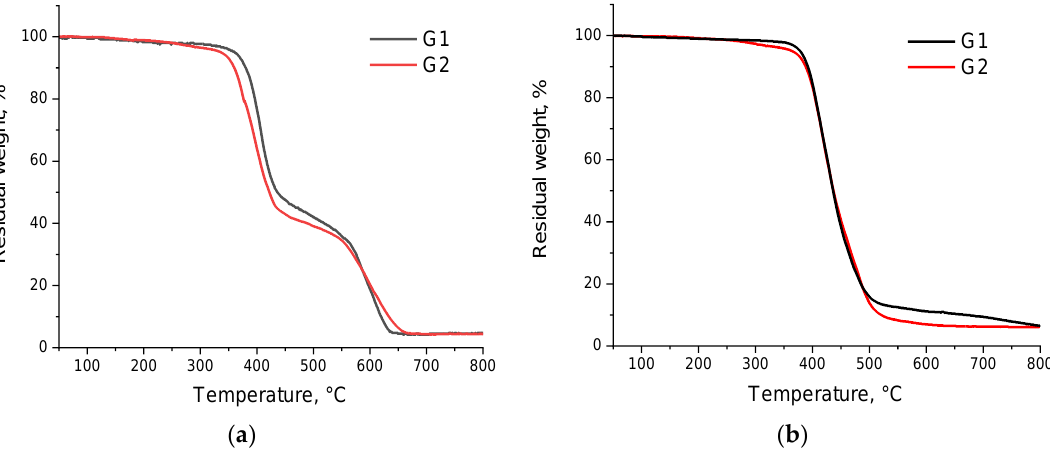
Figure 1. TGA traces of dendrimers G1 and G2 in air ( a ) and in argon ( b ) at a heating rate of